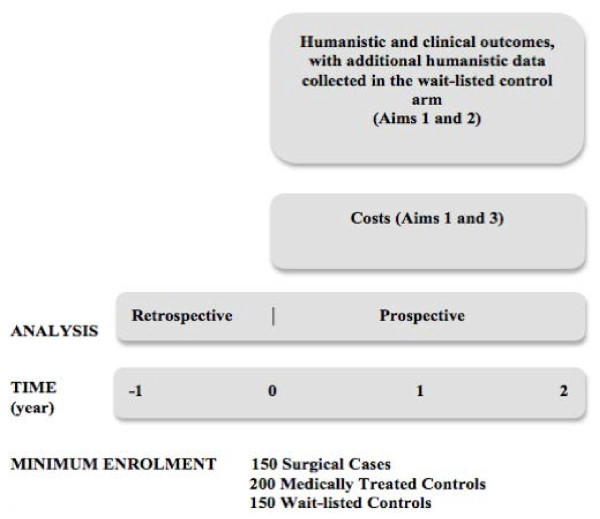
APPLES Study Design.